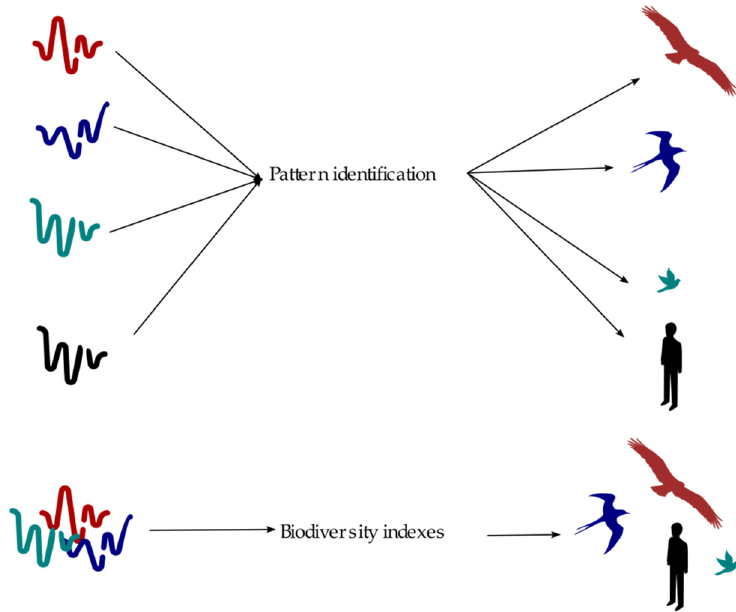
Figure 1. Stages in the CPS of the SCENA-RBD project.